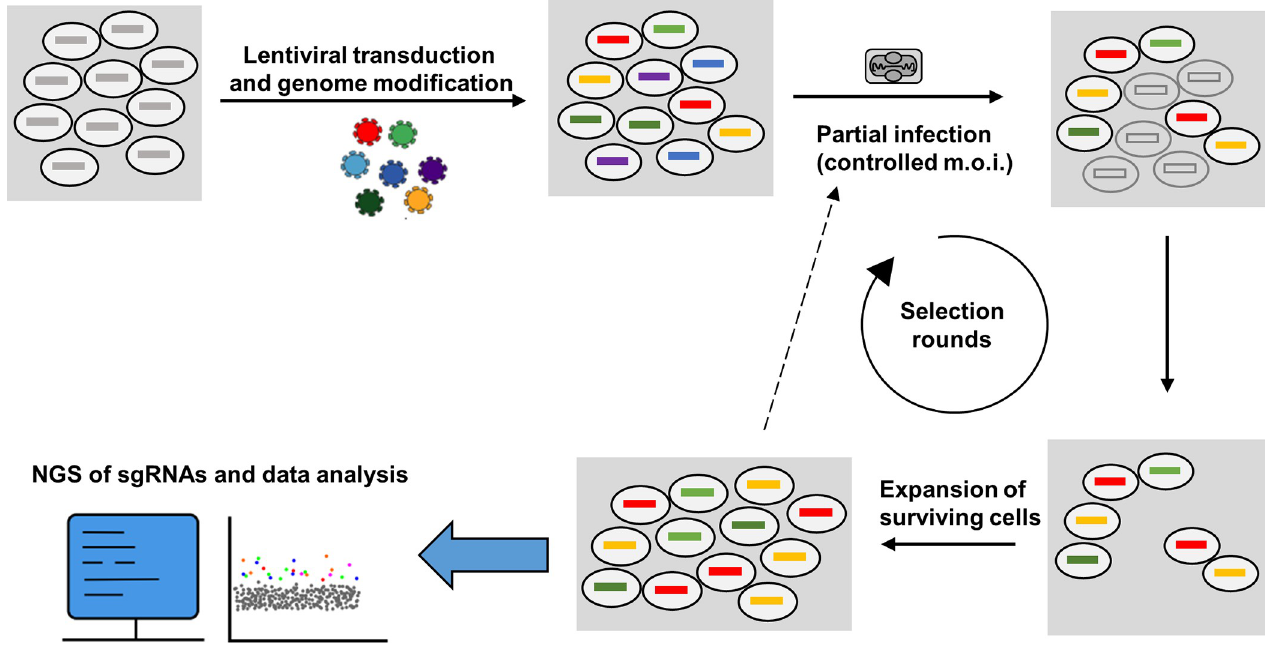
Fig 1. Design of the pooled genetic screen for the identification of VV pro-viral factors. A pool of cells with single gene inactivations was obtained by transducing the GeCKO sgRNA lentiviral library. Subsequently, the cell population is subjected to consecutive rounds of infection to enrich for resistant cells. Surviving cells are analyzed by high-throughput sequencing of the sgRNA region in the integrated lentiviral construct, which was amplified by PCR. Finally, results are analyzed using MaGeCK and ScreenBEAM algorithms for hit determination.